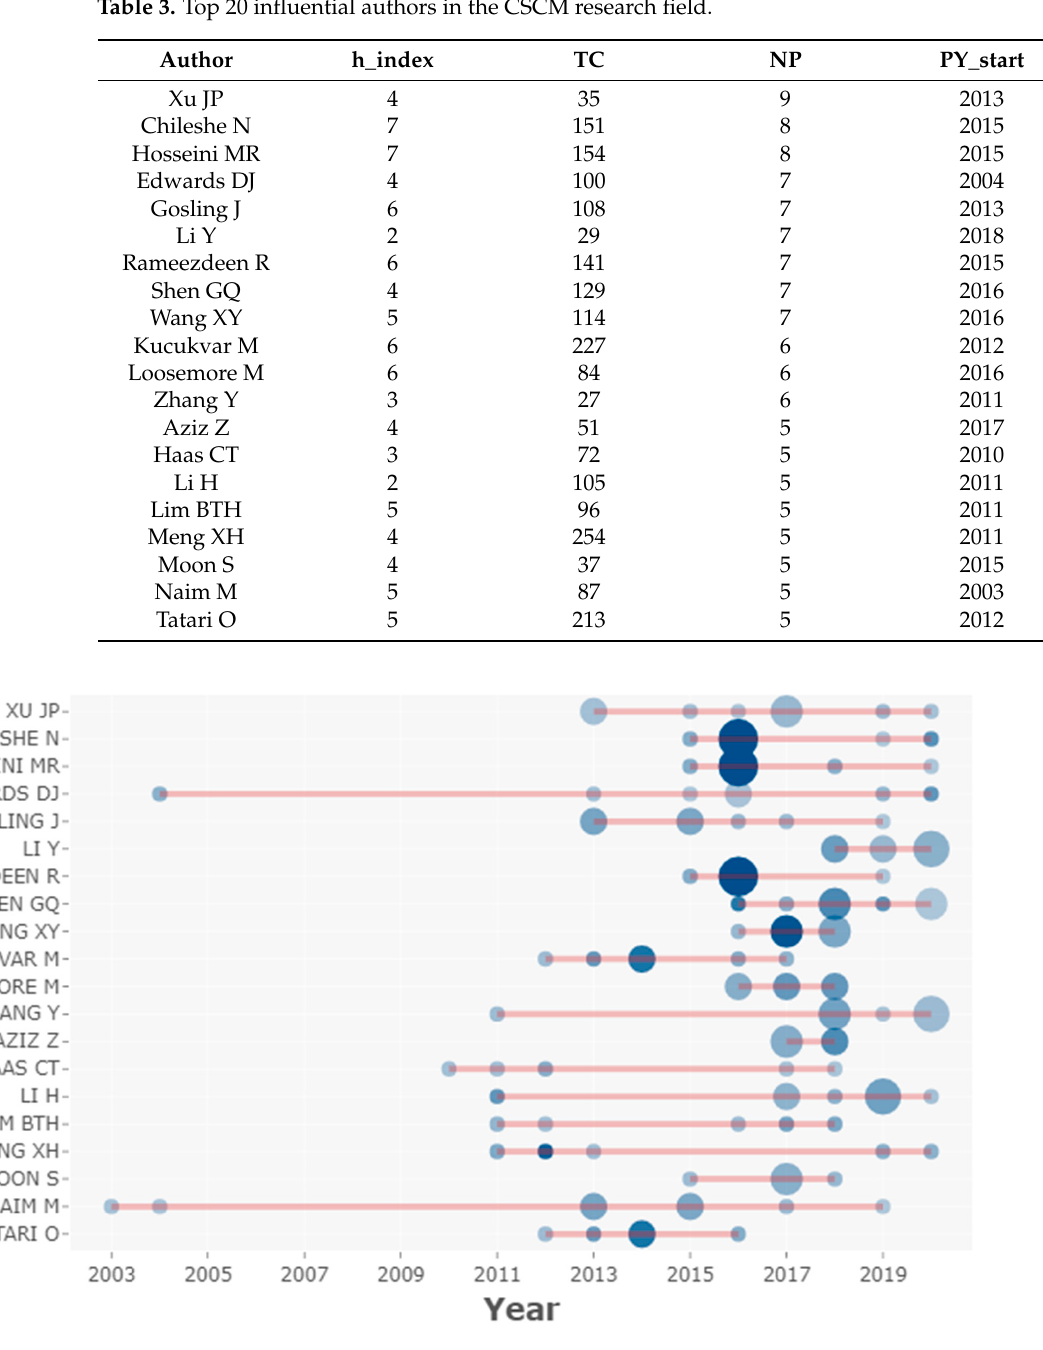
Figure 7 . Top 20 authors’ publications over time in the CSCM research field . Figure 7. Top 20 authors’ publications over time in the CSCM research Table 3. Top 20 influential authors in the CSCM research field .